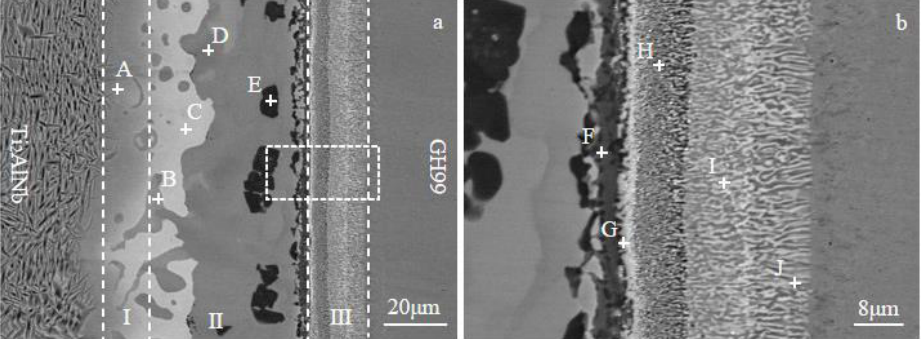
Figure 4. Interfacial microstructure of Ti 2 AlNb/GH99 brazed joint (1000 °C/10 min). ( a ) Microstruc- ture of joint interface; ( b ) the GH99 side. Table 2. EDS analysis of the different phases in Figure 4 (at. %).